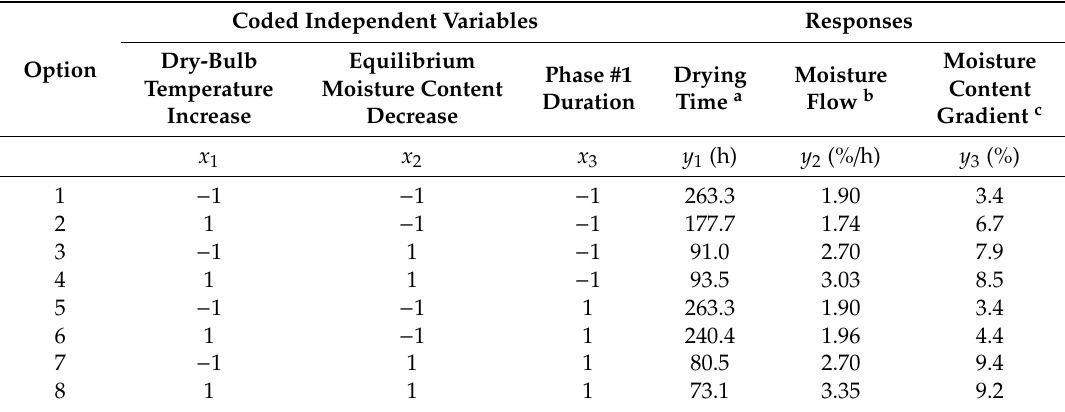
Table 4. Experimental (input) data for the response surface methodology (RSM) model.